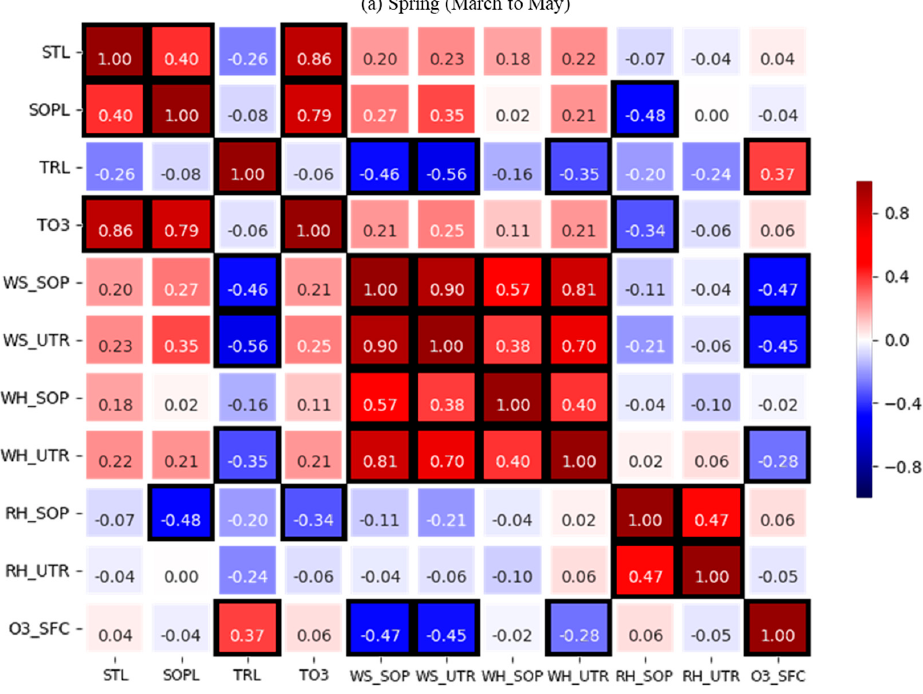
Figure 4. Correlation heatmap of each component (STL: stratospheric layer, SOPL: second ozone peak layer, TRL: tropospheric layer, TO3: total ozone, WS_SOP: wind speed of SOPL, WS_UTR: wind speed of the upper troposphere (3–9 km), WH_SOP: wind shear of SOPL, WH_UTR: wind shear of upper troposphere, RH_SOP: relative humidity of SOPL, RH_UTR: relative humidity of the upper troposphere, O3_SFC: surface ozone) for ( a ) spring, and ( b ) summer seasons. The black boundary line of each box represents the correlation values with a p -value < 0.05.